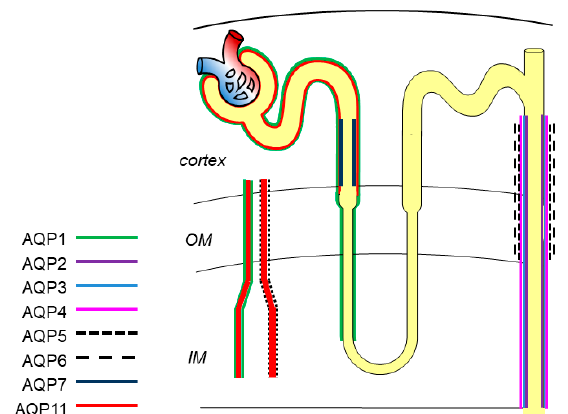
Figure 1. Expression localization of AQPs in kidney. AQP1 is located in proximal tubule, descending thin limbs of Henle, and vasa recta; AQP2, AQP3, AQP4, AQP5 and AQP6 are in the collecting duct; AQP7 and AQP11 are expressed in proximal tubule.